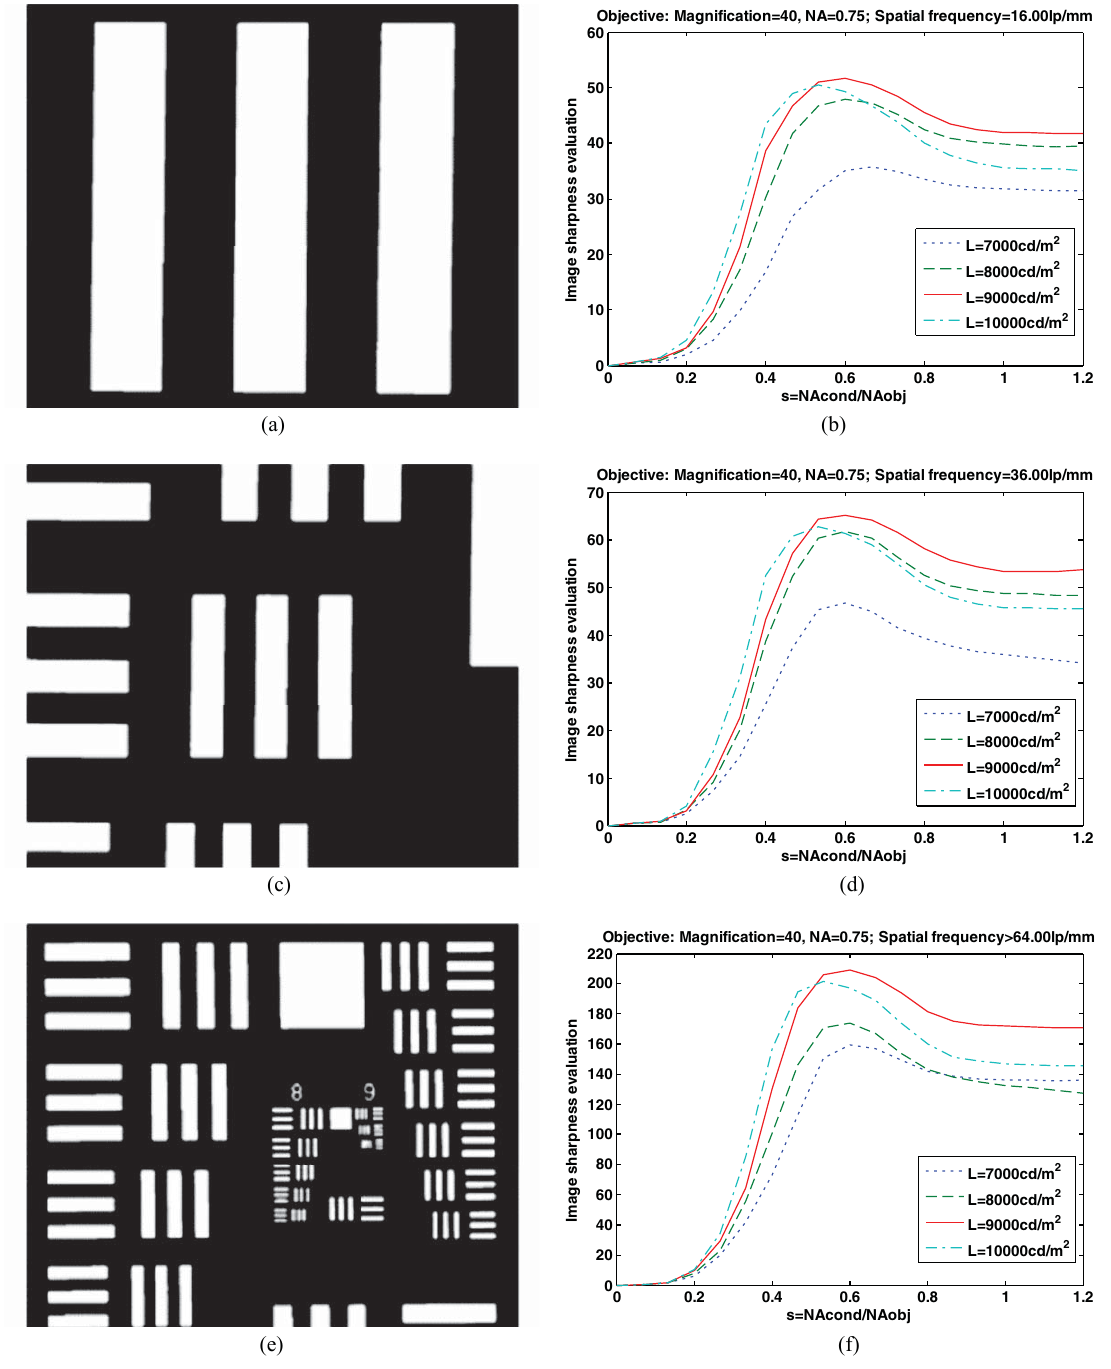
Fig. 5. The image sharpness measurements under 40 × (dry, NA obj = 0 . 75) with illumination intensity in the range of L=7000–10000cd/m 2 ; the L subjects to various systems; (a) f = 16.00lp/mm; (b) the measuring results of (a); (c) f = 36.00lp/mm; (d) the measuring results of (c); (e) f > 64.00lp/mm; (f) the measuring results of